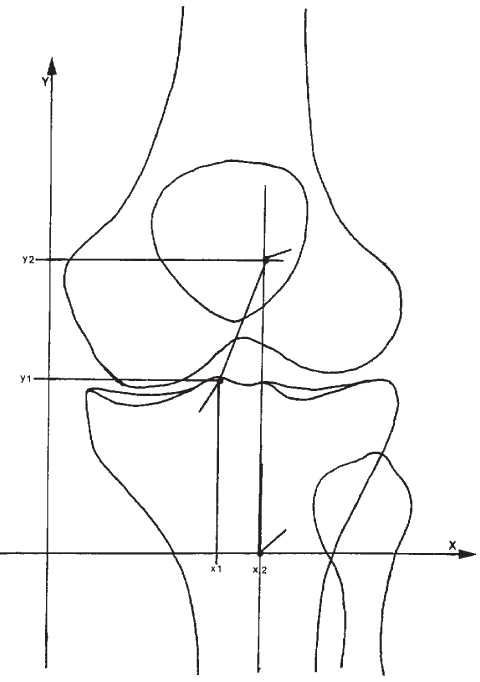
Figure 2 - Schematic drawing of Figure 1 showing the segment described as posterior bundle of anterior cruciate ligament and the projections on the y and z coordinates, drawn in relation to the tibial anatomic axis. The value of the segment for each bundle was found by subtracting coordinate values referring to femoral and tibial attachments, as follows: for the length in the y-axis, Y = y -y , and for length in the z-axis, Z = z 2 1